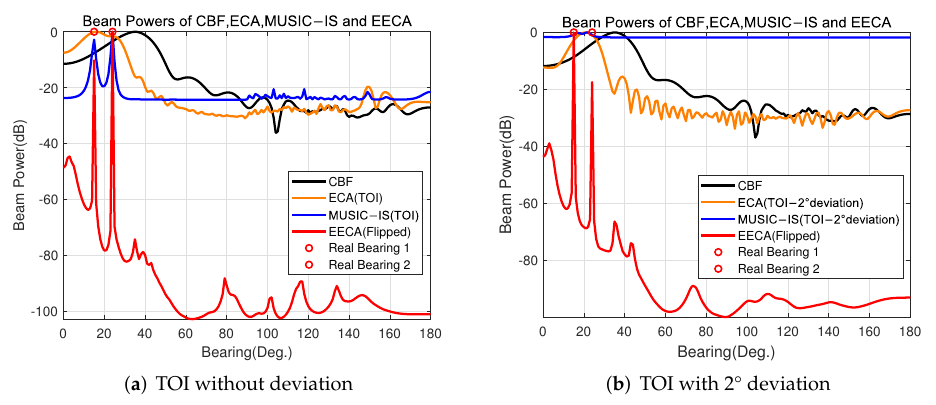
Figure 5. Comparison of beam power spectra among the CBF, ECA, MUSIC-IS, and EECA in Scenario II.